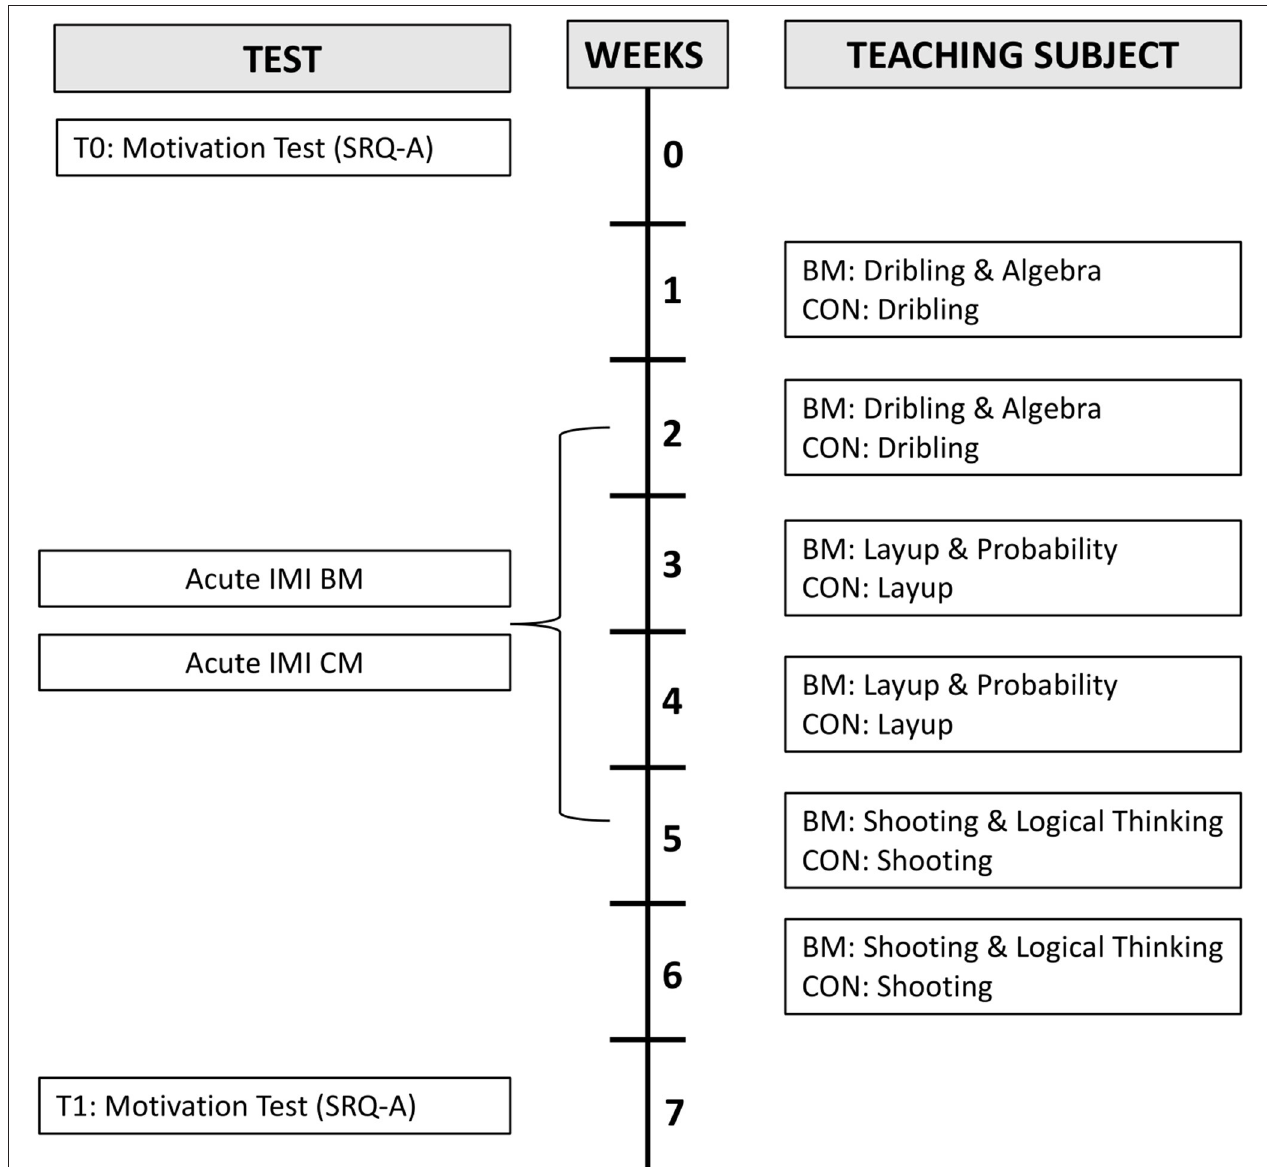
FIGURE 2 | Intervention overview. Two groups (BM: Basketball combined with Mathematics and CON: Basketball without mathematics) were tested before (T0) and after (T1) an intervention period of 6 weeks with an SRQ-A motivation questionnaire. Within the BM-group, the children performed acutely motivation questionnaire (IMI) in basketball sessions combined with mathematics (Acute BM), and in classroom-based sessions with mathematics (Acute CM) randomly in week 2–5. The figure also shows the different teaching themes in CON and BM.